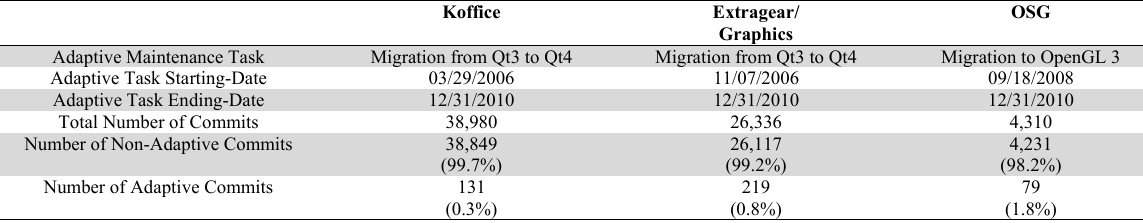
Adaptive And Non-Adaptive Commits For The Three Systems Over The Given Time